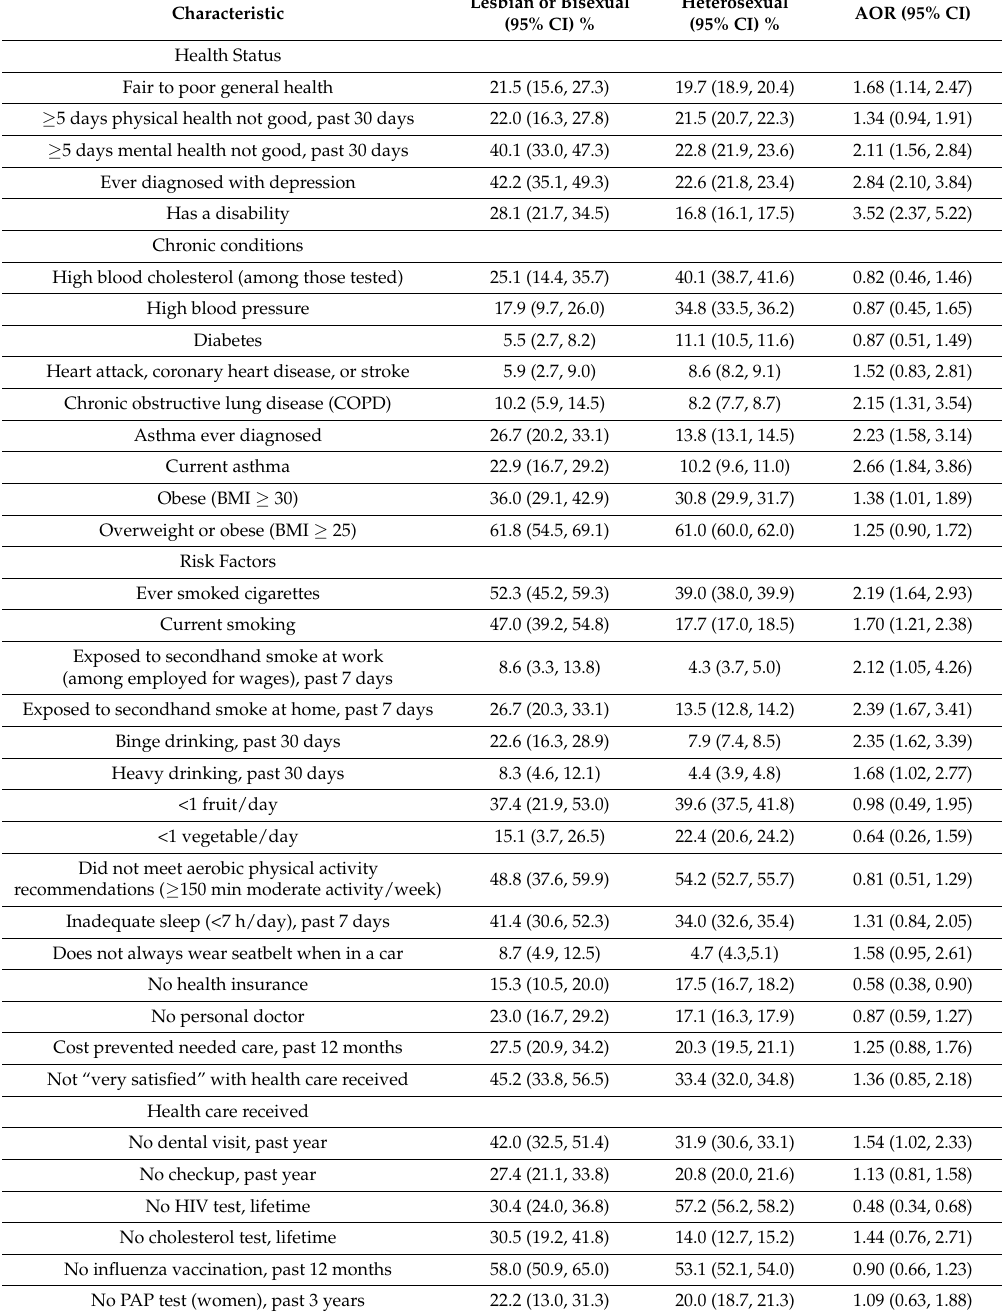
Table 3. Prevalence and 95% confidence intervals (CI) of selected health characteristics among adults by sexual orientation among women, and adjusted odds ratios (AOR), North Carolina Behavioral Risk Factor Surveillance System